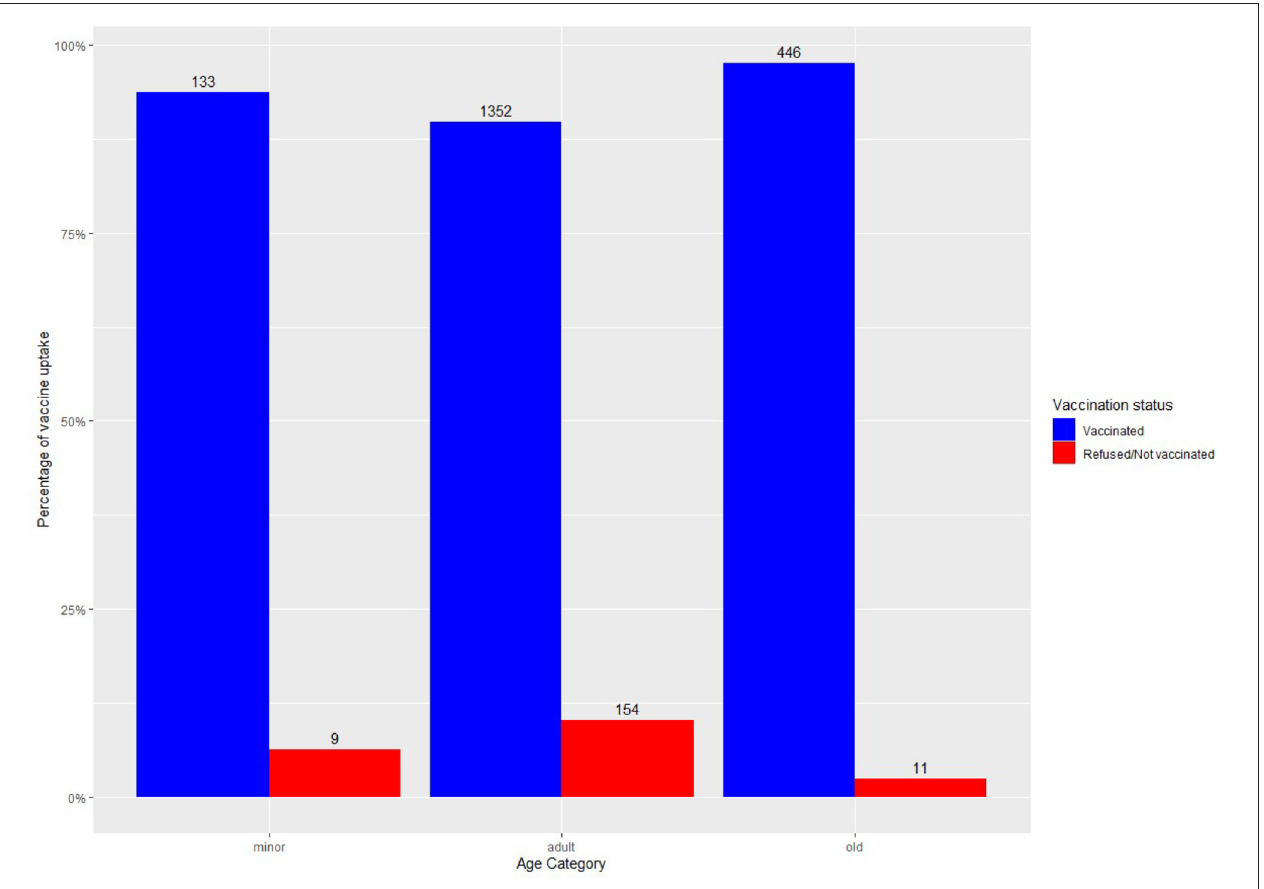
FIGURE 2 | Vaccine uptake per age